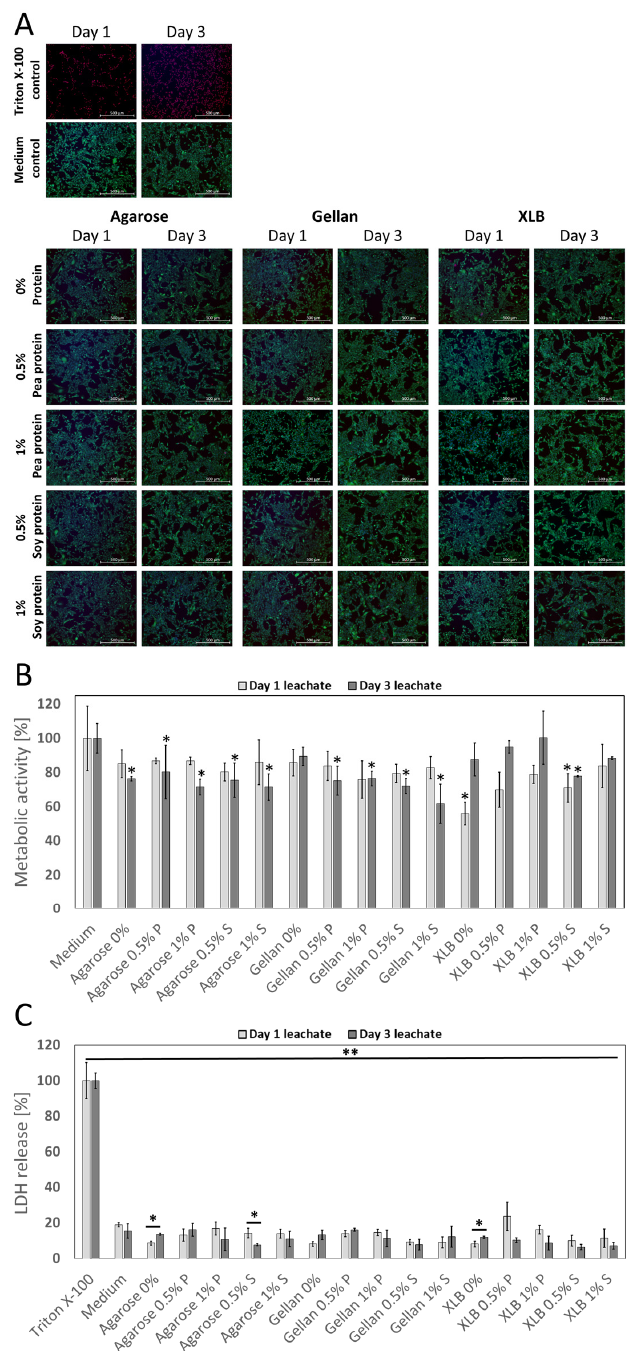
Figure 5. Biocompatibility testing using leachates (day 1 and day 3) of agarose, gellan and XLB gels blended with 0%, 0.5% and 1% of pea or soy protein with one day incubation on C2C12 cells. ( A ) Live/Dead-staining of C2C12 cell. Green: viable cells; red: dead cells; blue: DNA/cell nuclei. Scale bar: 500 µm. ( B ) Metabolic activity of C2C12 after one day treatment with different leachates (day 1 and day 3) relative to medium control (medium treated same as leachates) (n = 3, two-sided t student test * p < 0.05 respectively to medium control). ( C ) LDH release of C2C12 cells after one day treatment with different leachates (day 1 and day 3) relative to 0.1% TritonX-100 treated cells. (n = 3, two-sided t student test * p < 0.05, ** p < 0.01). Error bars represent standard deviations.